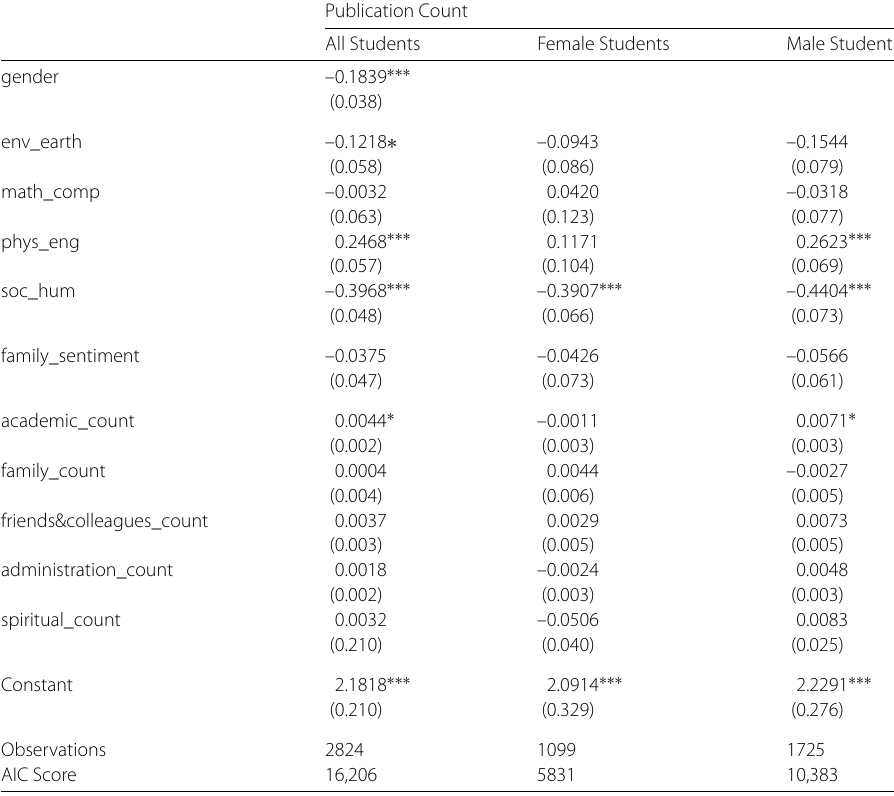
Table 1 Regression results. Inverse Gaussian model for explaining productivity by gender, discipline and textual features extracted from dissertation